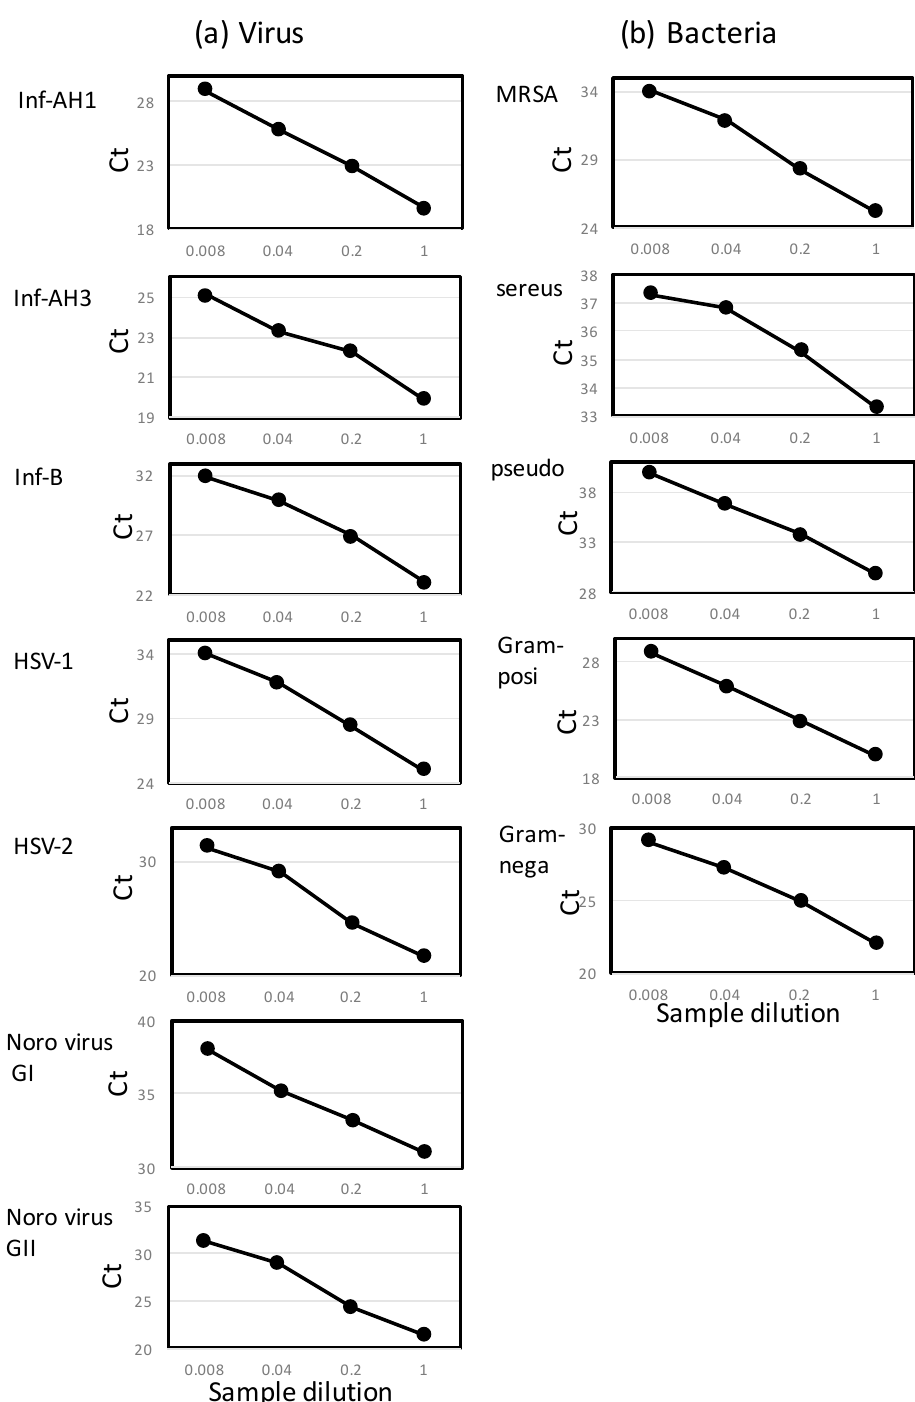
Figure 3. Standard curves generated from serial dilution of RNA from virus ( a ) and bacteria ( b